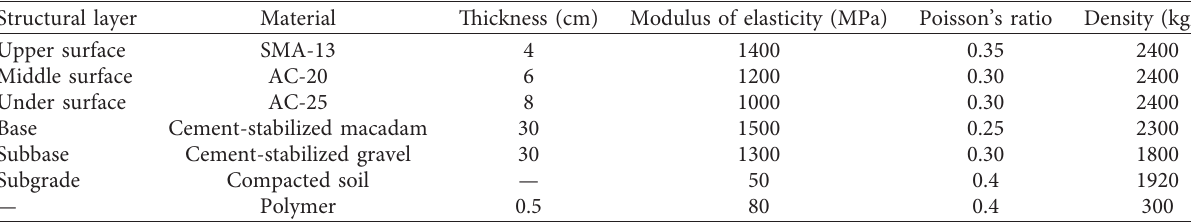
Table 3: Road structure and related parameters of polymer grouting materials.